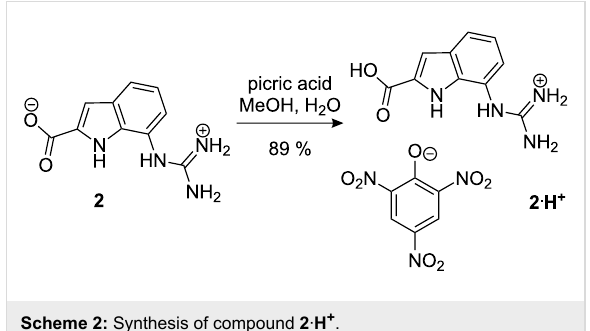
Scheme 2: Synthesis of compound 2 · H +